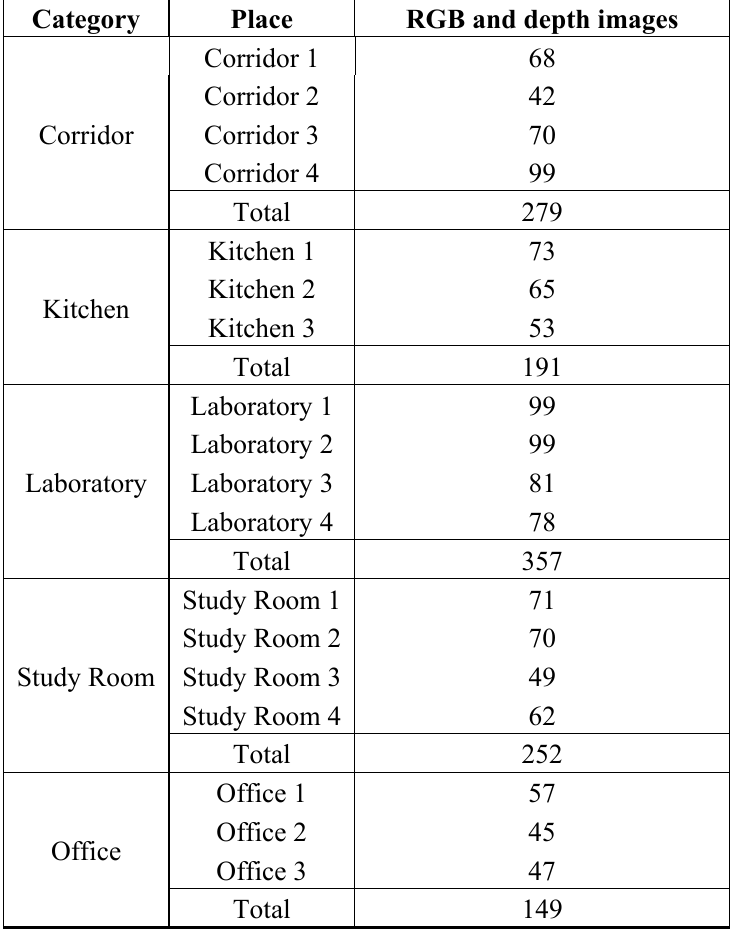
Figure 4. Examples of RGB and depth images for the places in each category. Corridor